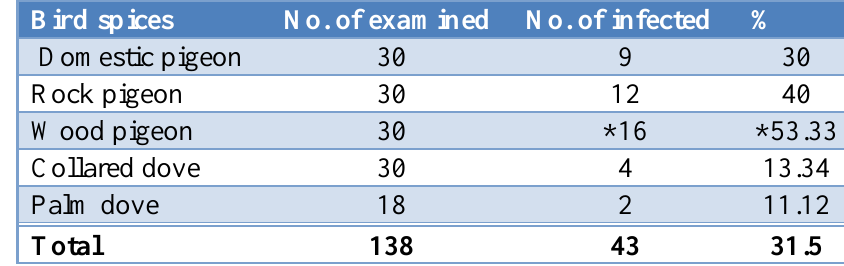
Table, 3: The prevalence of trichomonoasis according to sex. Bird spices Domestic pigeon Rock pigeon Wood pigeon Collared dove